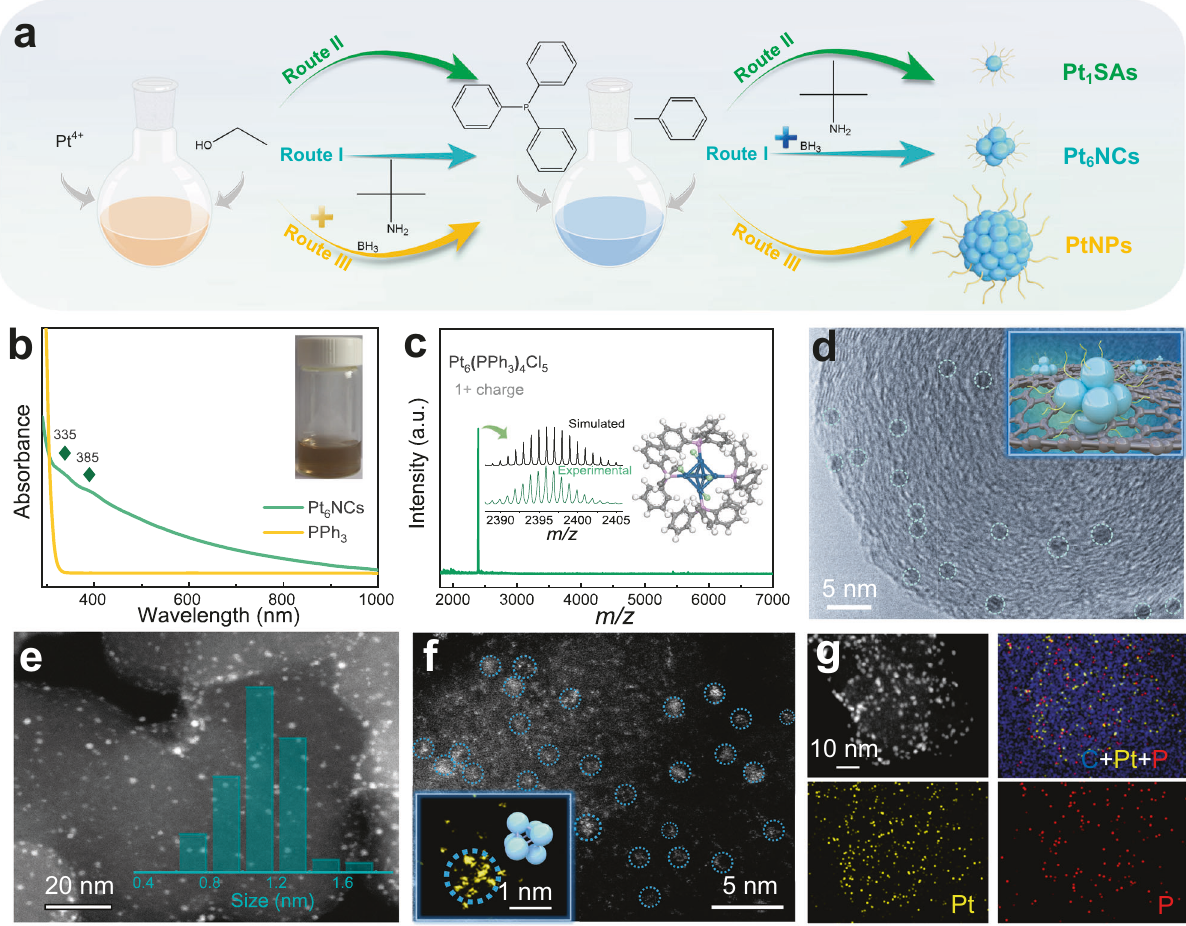
Fig. 1 Synthesis, morphological, and structural characterization of Pt 6 NCs. a Schematic representation of the synthetic routes for PPh 3 -protected Pt- based catalysts: Pt 1 SAs, Pt 6 NCs, and large-sized PtNPs. b UV-vis absorption spectra of Pt 6 NCs and PPh 3 ; inset: the photographic image of the Pt 6 NCs suspension. c ESI-MS spectrum of Pt 6 NCs (measured in positive mode); inset: (left) experimentally obtained (green curve) and simulated (black curve) isotope patterns of Pt 6 (PPh 3 ) 4 Cl 5 ; (right) a simulated structure model of a Pt 6 NC; The gray, white, blue, pink, and reseda spheres represent C, H, Pt, P, and Cl atoms, respectively. d TEM image of Pt 6 NCs/C; inset: schematic diagram of carbon-supported Pt 6 NCs. e HAADF-STEM image of Pt 6 NCs/C; inset: size distribution of Pt 6 NCs. f Aberration-corrected HAADF-STEM image of Pt 6 NCs/C; inset: the magni fi ed image of a Pt 6 NCs and corresponding model. g Corresponding element maps of Pt 6 NCs/C showing distributions of C (blue), Pt (yellow), and P (red),